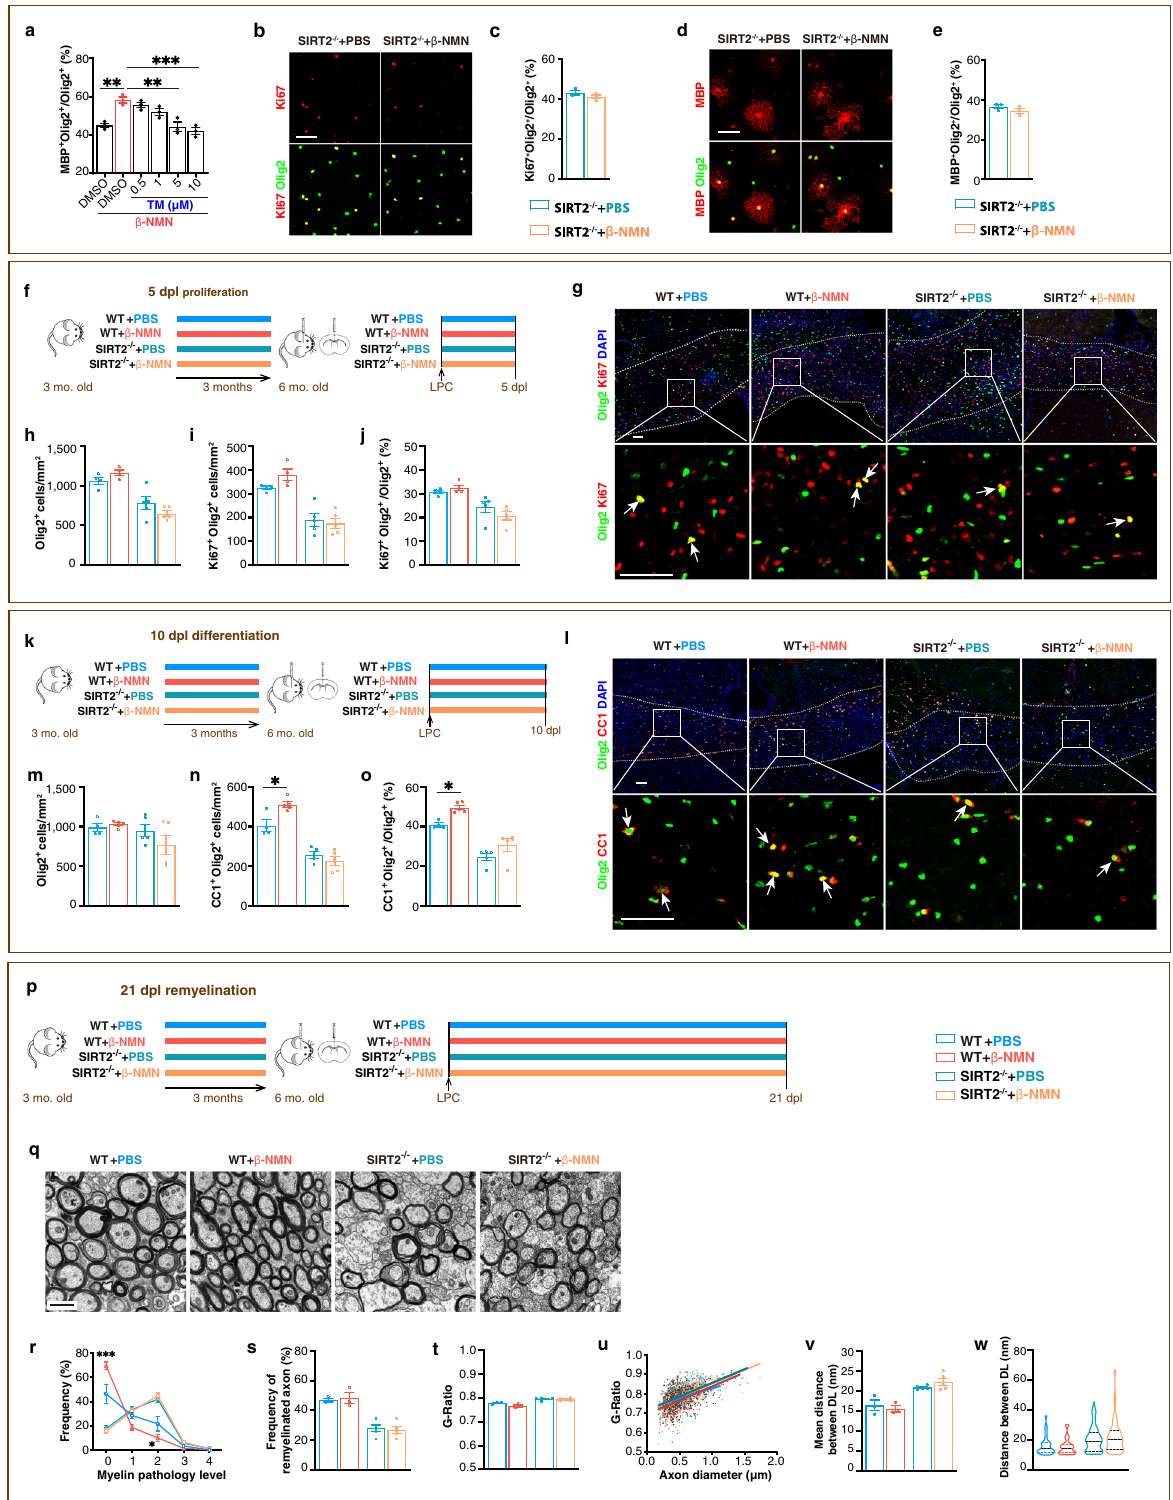
Immuno fl uorescence for cells . Cultured cells were rinsed with PBS three times and fi xed with 4% paraformaldehyde (PFA) for 10min at room temperature (RT). Then the cells were washed three times with PBS and blocked with 5% normal donkey serum (NDS, #D9663, Sigma), 0.3% Triton X-100 (#T8787, Sigma) in PBS for 2h at 4°C. The cells were then incubated with primary antibodies (diluted with 2.5% NDS, 0.3% Triton X-100 in PBS) for 4h at RT and then washed with PBS for three times. Primary antibodies used in this study include: rat anti-Ki67 (#14-5698-82, Thermo